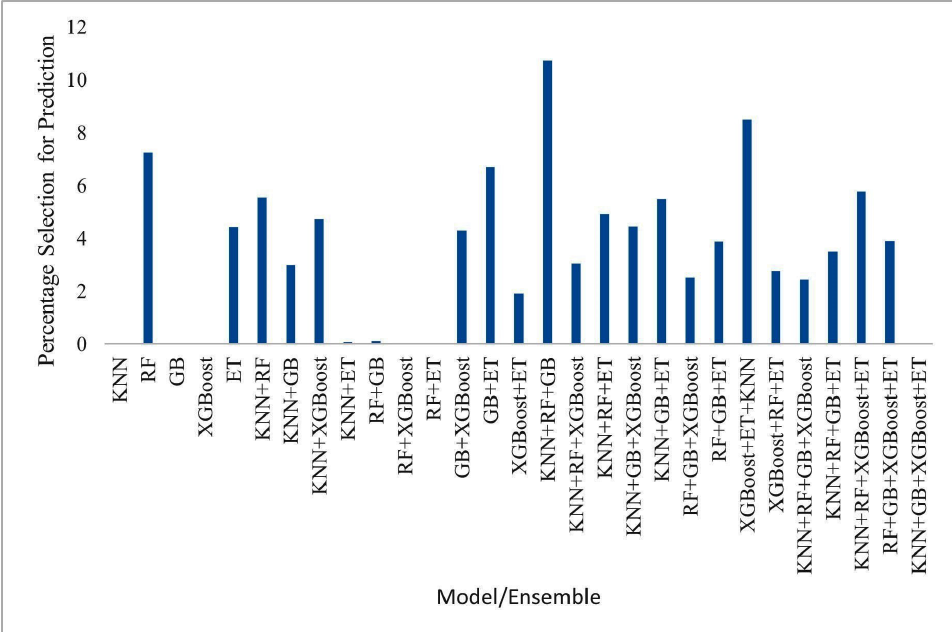
Figure 15. Percentage of model/ensemble selection in DES for dataset